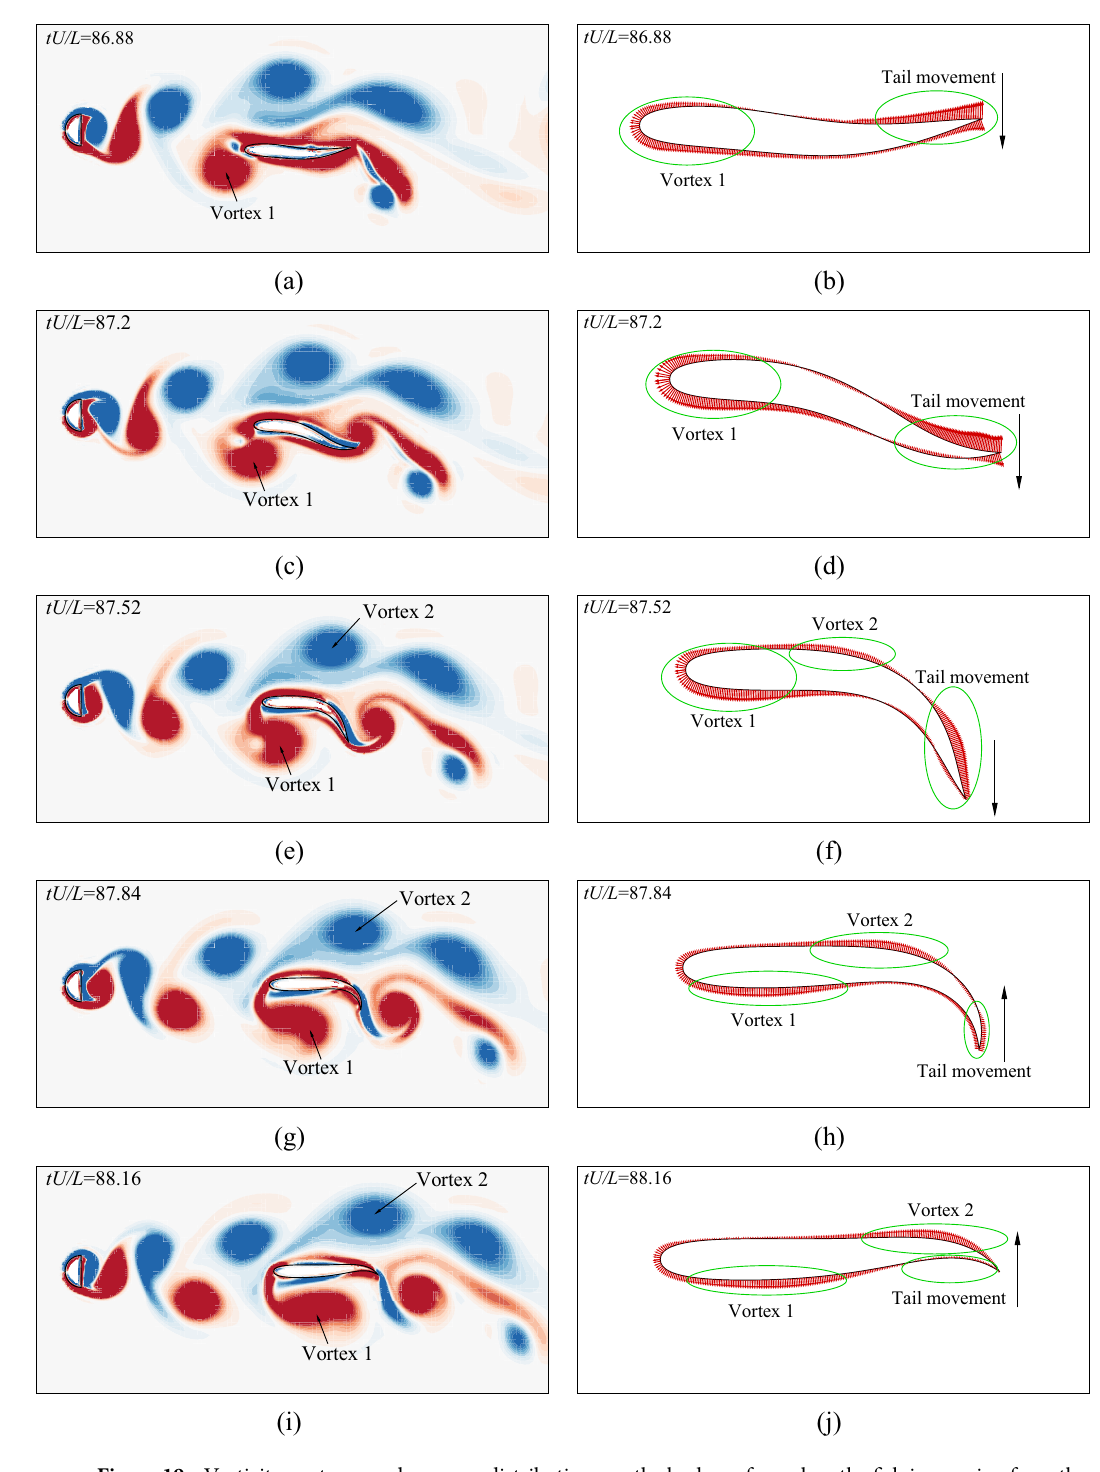
Figure 19. Vorticity contours and pressure distributions on the body surface when the fish is escaping from the 86.88 , ( b ) pressure at tU / L 86.88 , ( c ) vorticity at tU / L 87.2 , ( d ) pressure vortices: ( a ) vorticity at tU / L = = = 87.2 , ( e ) vorticity at tU / L 87.52 , ( f ) pressure at tU / L 87.52 , ( g ) vorticity at tU / L 87.84 , ( h ) at tU / L = = = = 87.84 , ( i ) vorticity at tU / L 88.16 , and ( j ) pressure at tU / L 88.16 . The range of the pressure at tU / L = = = 4 to 4. Flow visualization is achieved by using Tecplot 360 EX 2015 R2 (https ://www. vorticity contours is from − tecpl